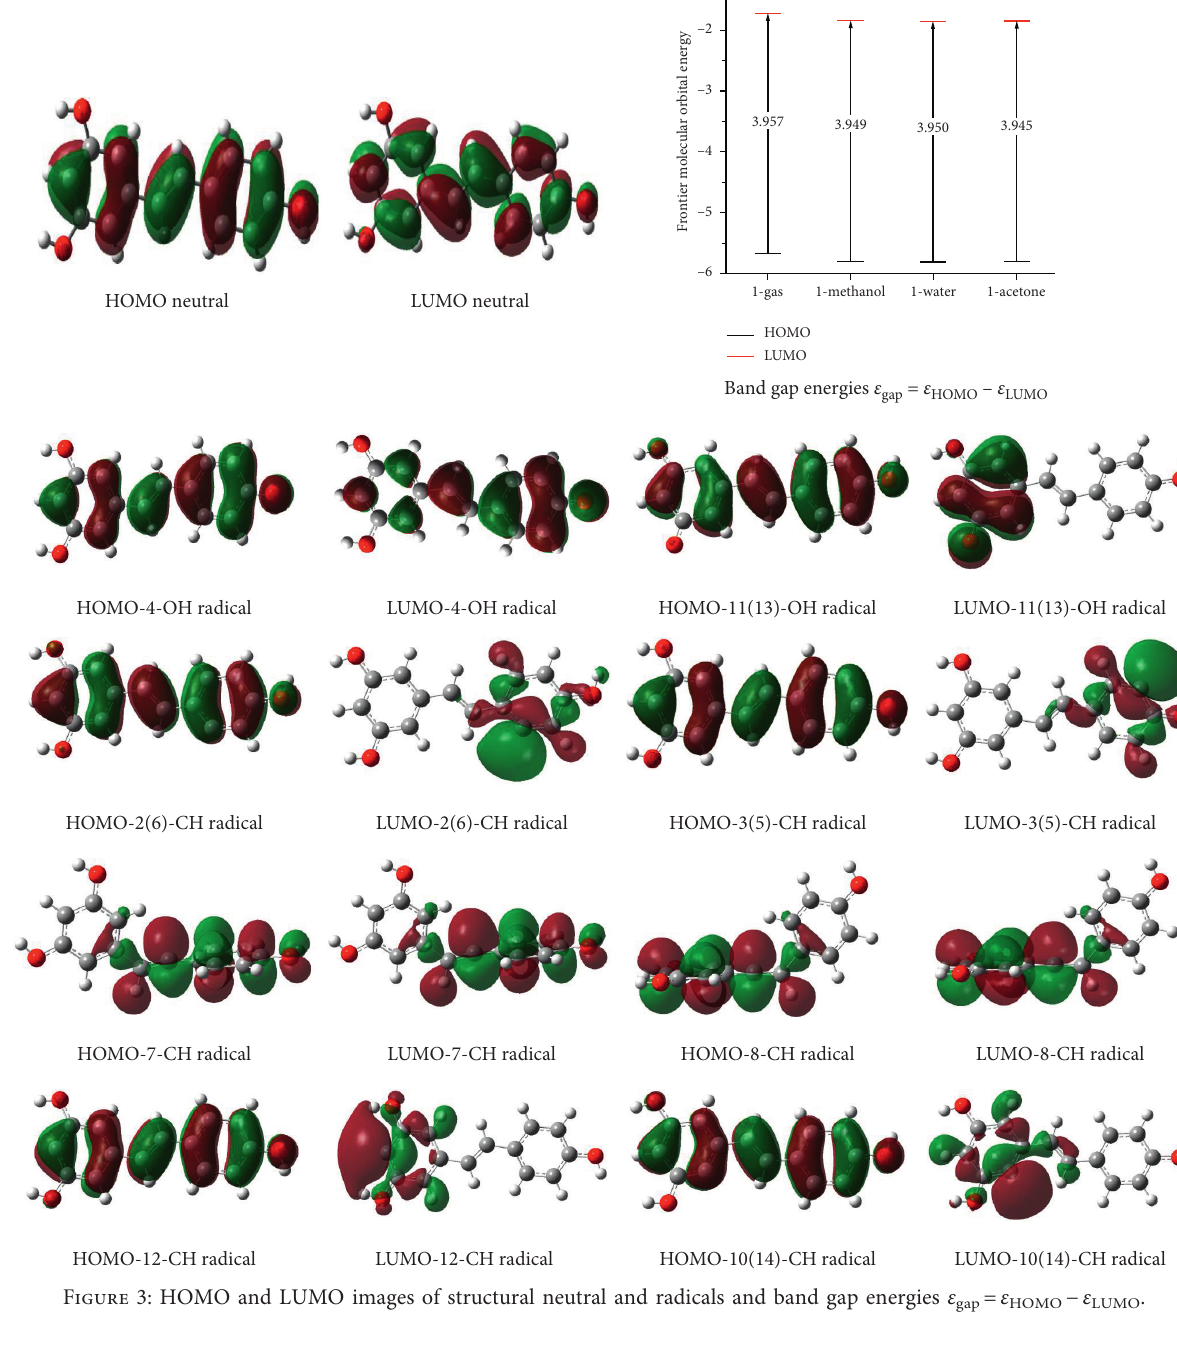
� ε − ε gap HOMO LUMO .